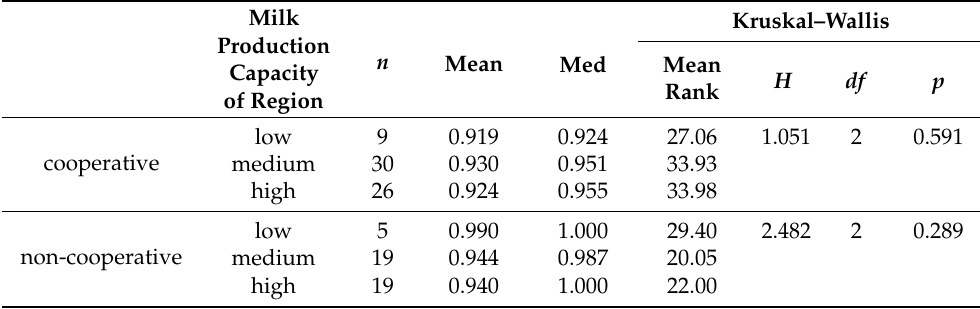
Table 13. Results of PTE scores analysis for cooperative and non-cooperative dairies by region of location (authors’ calculations based on